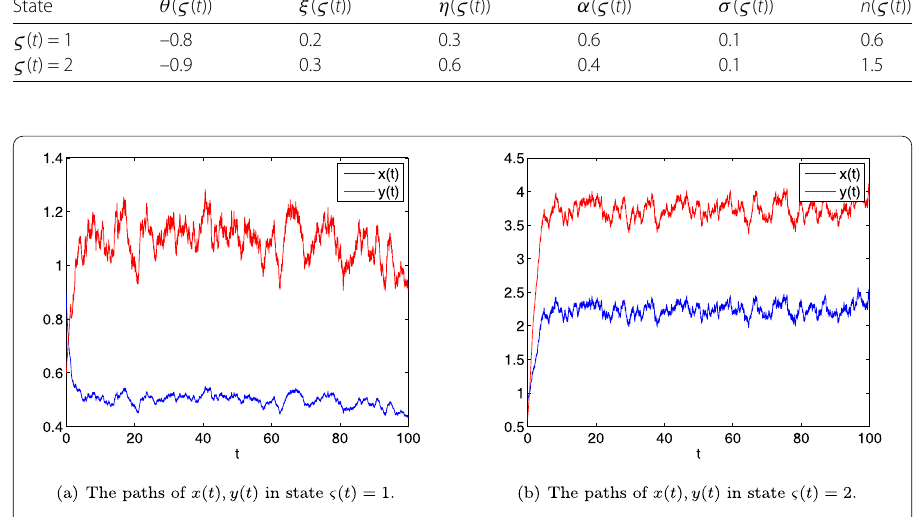
Figure 3 The time-series plots of x ( t ) and y ( t ) for model (4) with initial ( x 0 , y 0 ) = (0.2,0.8), and other parameters are taken as in Table 3